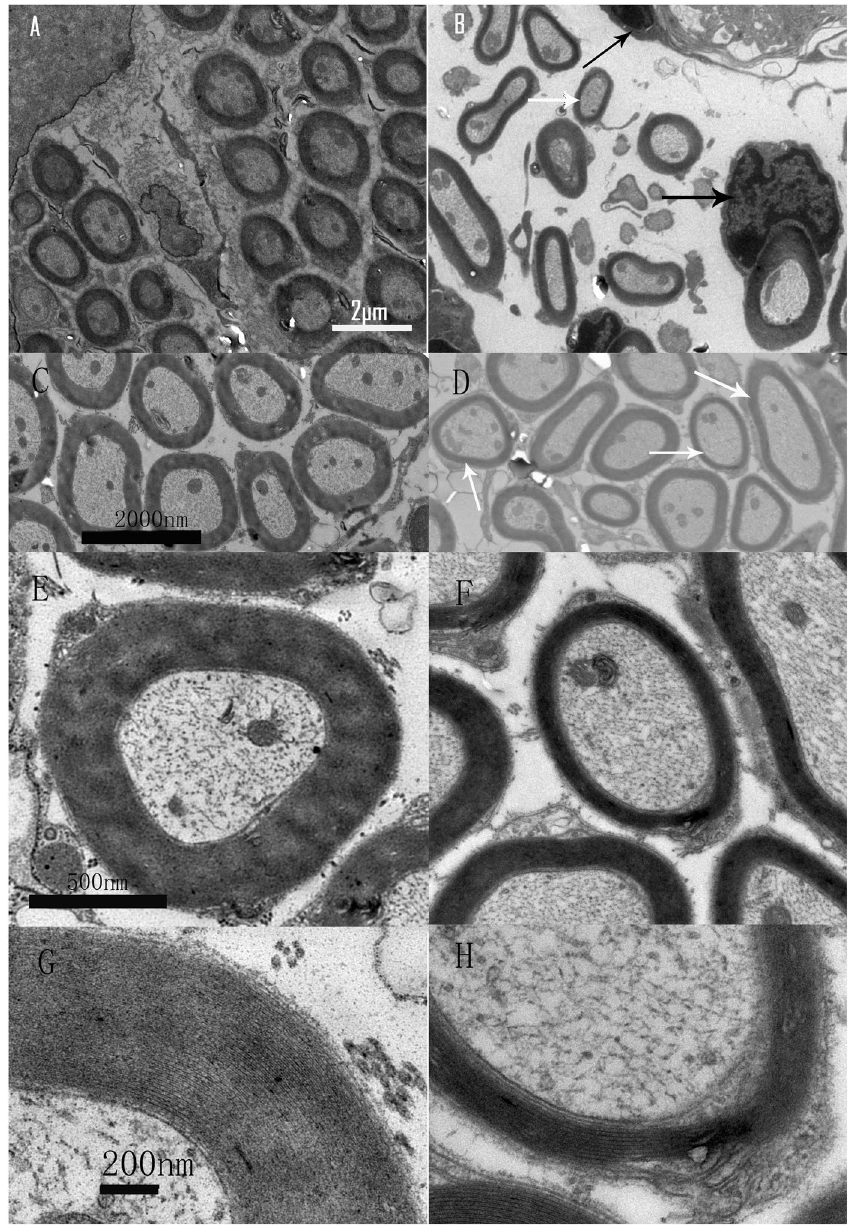
Figure 6. TEM images showing DT-induced ANF damage. Magnification was 6000 × , 20000 × , and 50000 × in A–D, E and F, and G and H, respectively. The images in the left and right columns are from the control and Cre + groups, respectively. The cross sections of ANFs were in regular round shape ( A , C ) with relatively even thickness of myelin sheaths, in contrast to the irregular shape and uneven thickness of myelin sheaths in the images from the Cre + group ( B , D ). The white arrows in ( B and D) point to nerve fibers whose myelin sheath was peeling off. Additionally, extremely swollen Schwann cells were seen in the Cre + sample (black arrows in B and D ). The images of higher magnification ( E – H ) show that the myelin sheaths in the Cre + sample is thin ( F ) and loosely packed ( H ) as compared with the control sample ( E and G